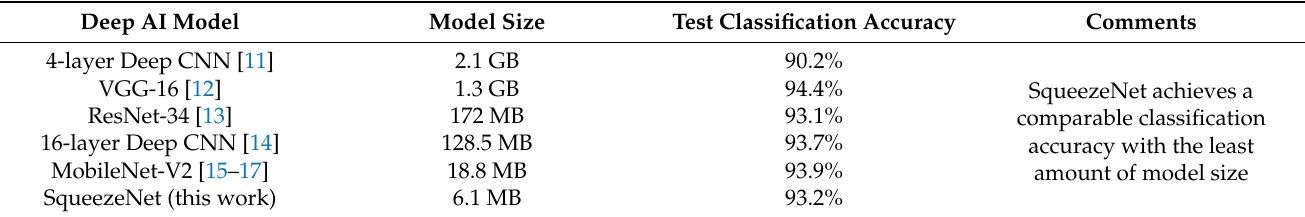
Table 5. Size and accuracy comparison of potential deep AI models without any weight